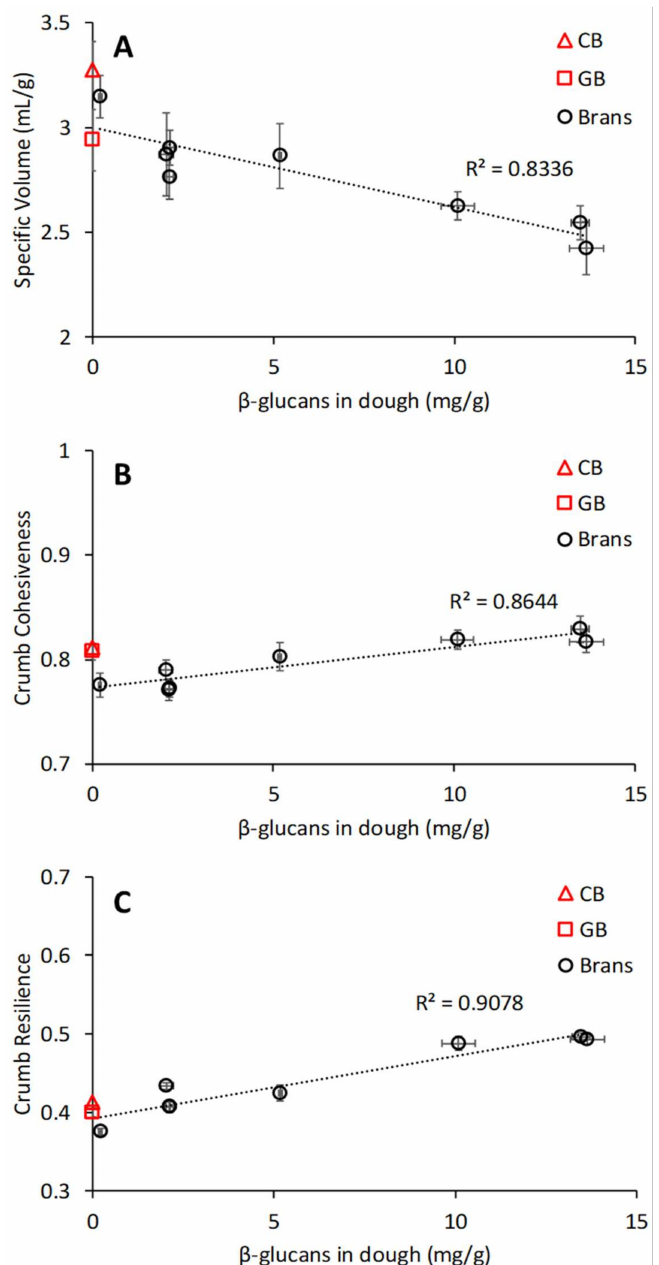
Figure 8. Association between the β -glucan contents in the dough and some bread quality parameters: specific volume ( A ), crumb cohesiveness ( B ), and crumb resilience ( C ). CB = control dough and GB = dough with glass